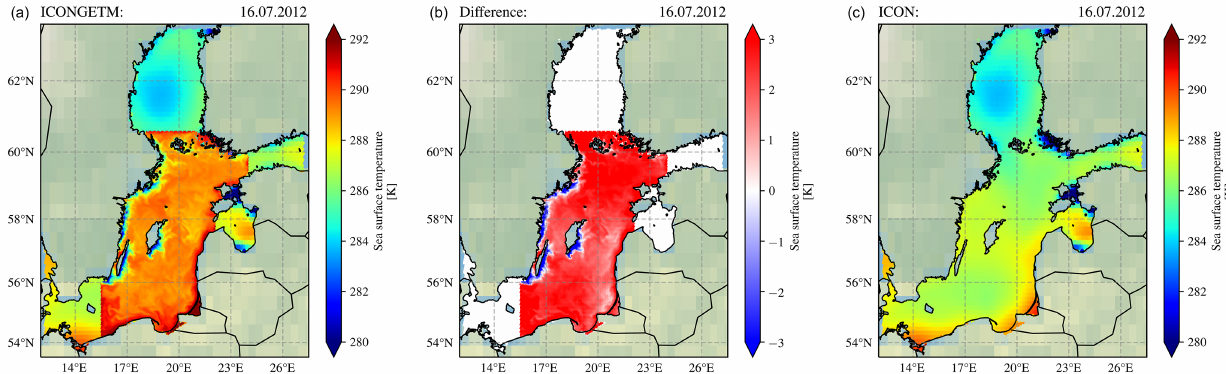
Figure 7. Daily mean sea surface temperature (SST) from the two-way coupled ICONGETM run (a) and the uncoupled/one-way coupled ICON run (c) as well as the difference ICONGETM minus ICON (b) for 16 July 2012. Outside the domain of simulated SST in the central Baltic Sea, the two-way coupled ICONGETM run also uses the prescribed ICON-internal SST.